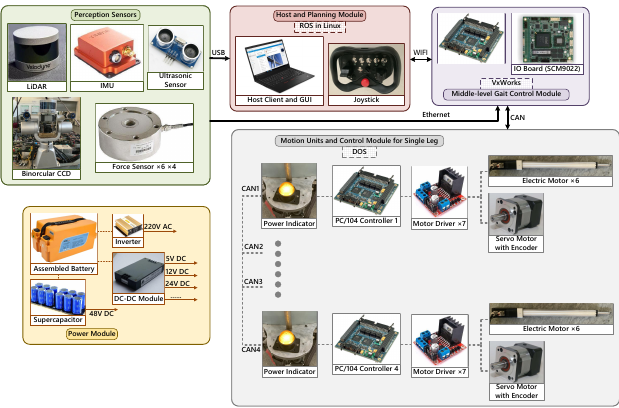
Figure 2. The hardware and software components of the WLHR